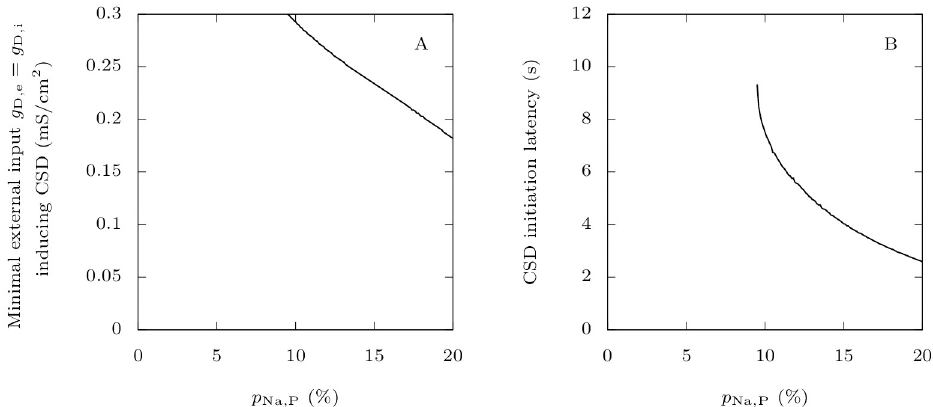
Fig 6. Effect of FHM-3 mutations on CSD initiation. A : We show here how increasing the GABAergic neuron’s persistent sodium current influences the minimal external input necessary to induce a depolarization block in the pyramidal neuron, varying p Na,P from 0 to 20%. We used as external inputs constant excitatory conductances, equal for both neurons, taking values up to g D,i = g D,e = 0.3 mS � cm − 2 . We considered that beyond these values, inputs would be unrealistically strong, leading to a response of the model that would not be interpretable. Again, we chose as initial condition the steady state when the neurons are not stimulated. We defined a depolarization block by the absence of oscillations of amplitude larger than 5 mV of the voltage for at least half a second, with the additional condition that it must be between − 55 mV and − 20 mV at the end of this interval. For each p Na,P , we estimated the smaller external input for which this criterion is met for the pyramidal neuron with a bisection method. B : Starting from neurons at rest, for given large external inputs g D,e = g D,i = 0.3 mS � cm − 2 , we computed the time it takes for a CSD to be initiated, if it is initiated at